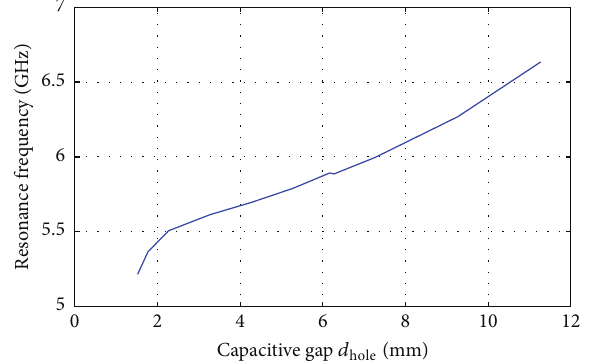
Figure 7: Impact of capacitive gap 𝑑 of the antenna.